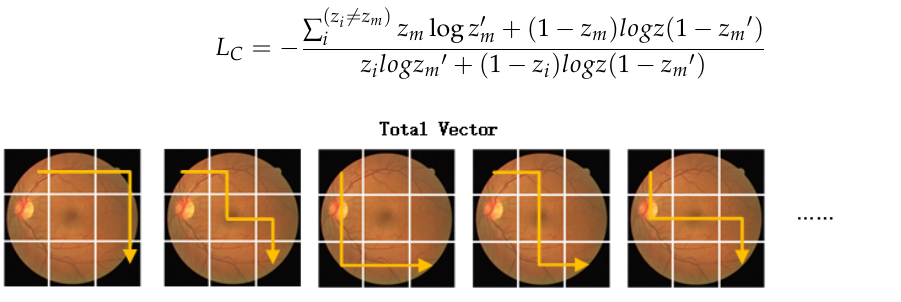
Figure 4. Total vector